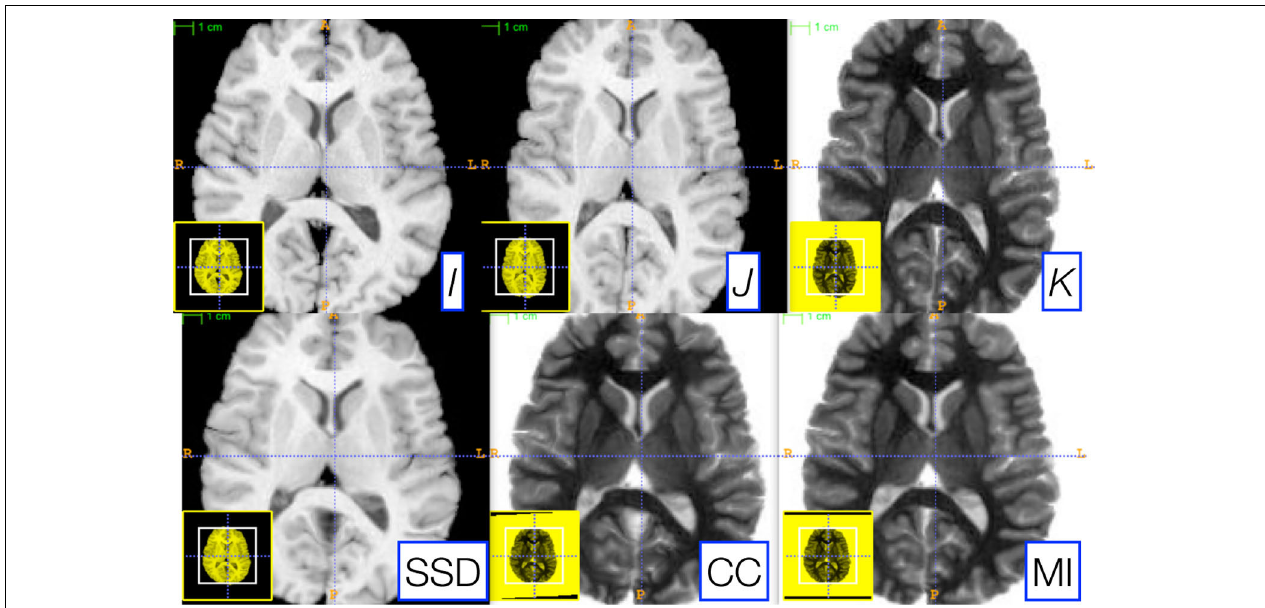
FIGURE 5 | Three reference images, I (left), J (middle top), and K (right top), are used to illustrate the robustness of our parameter scale estimation for setting consistent parameters across both metrics and transform types. K is the negation of J and is used to test the correlation and mutual information registrations. We optimized, by hand, the step-length parameters for one metric (the sum of squared differences) for both the